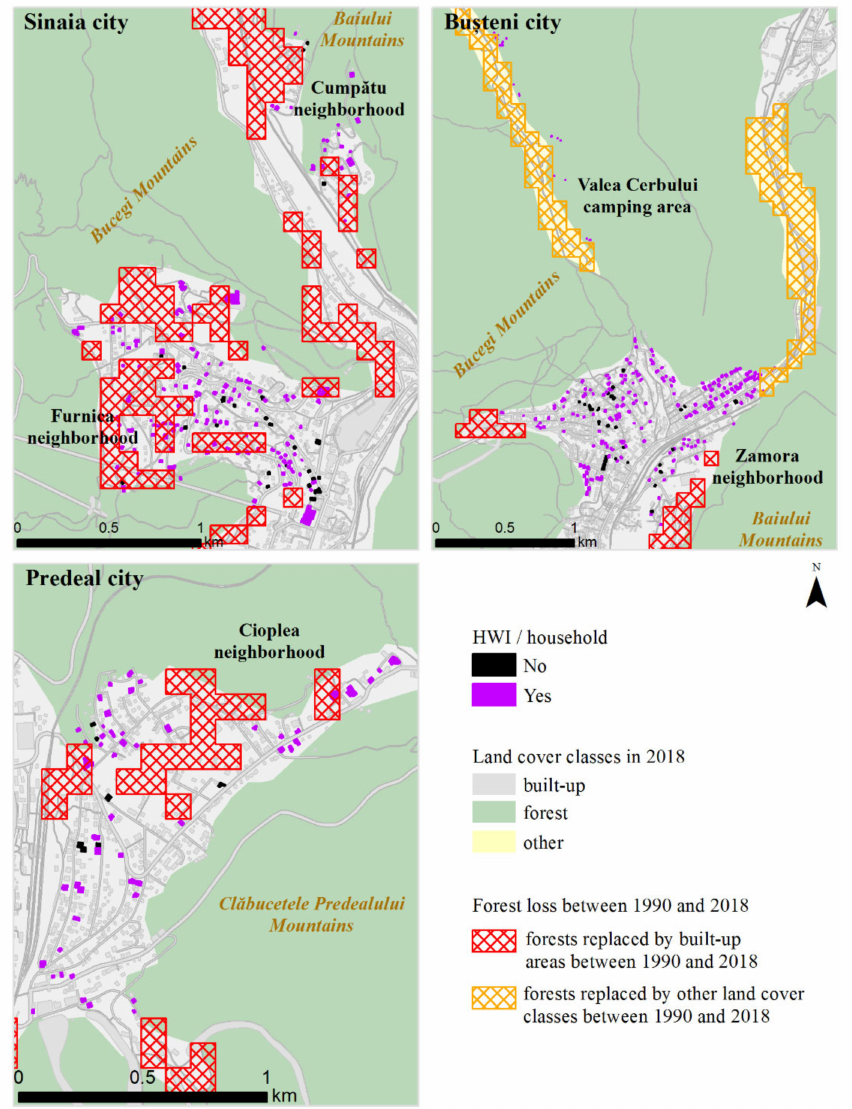
Figure 5. Map consisting in overlapping the location of households where HWI took place according to the respondents with the areas where forests were replaced by built-up and other land cover classes between 1990 and 2018 according to the Markov chains